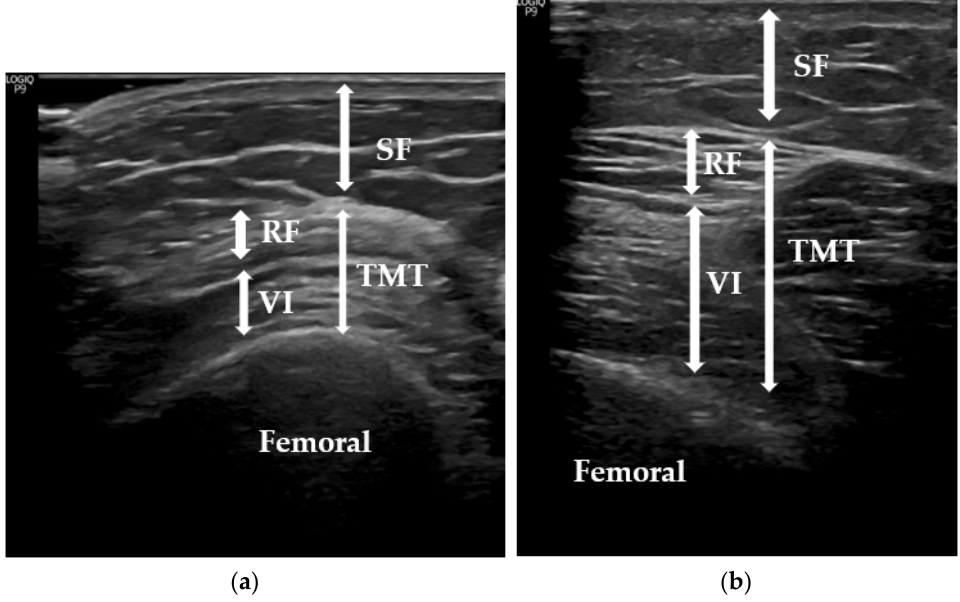
Figure 1. Measurement of subcutaneous tissue and thigh muscles using US. SF: subcutaneous fat; TMT: thigh muscle thickness; VI: vastus intermedius; RF: rectus femoris. ( a ) Representative image of a participant control of our sample; ( b ) representative image of a participant case (candidate for BS) of our sample.